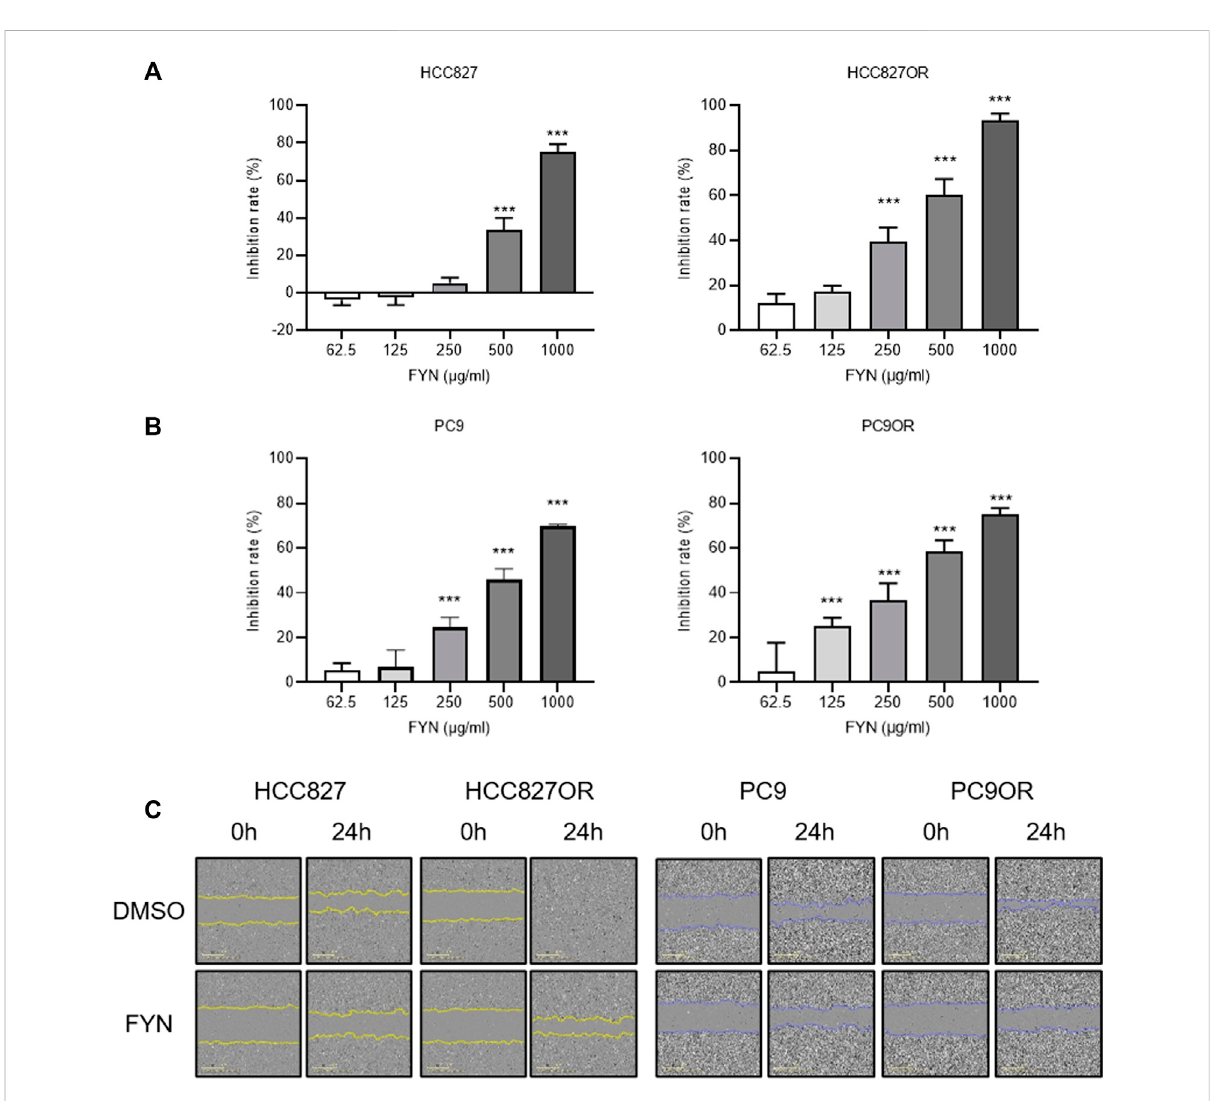
FIGURE 1 Effects of FYN on lung cancer cell proliferation and migration. (A,B) CCK8 results. HCC827 or HCC827OR cells (A) and PC9 or PC9OR cells (B) were treated with different concentrations of FYN for 48 h. (C) Cell migration was detected via wound healing assays. HCC827 or HCC827OR cells were treated for 24 h with 250 μ g/ml FYN, and PC9 or PC9OR cells were treated for 24 h with 125 μ g/ml FYN. * p < 0.05, ** p < 0.01, *** p <